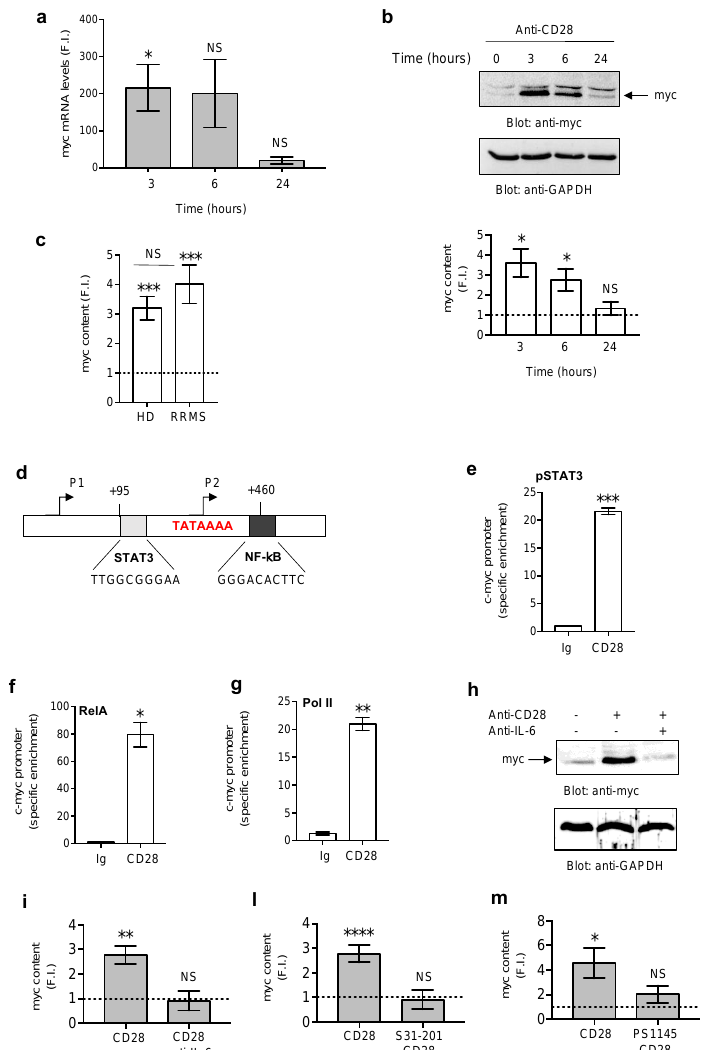
Figure 4. STAT3 and RelA / NF- κ B transcription factors regulate the transactivation of c-myc in response to CD28 stimulation. ( a ) Peripheral blood CD4 + T cells from HDs ( n = 3) were activated for 3, 6 or 24 h with isotype control Ig or anti-CD28.2 Abs and c-myc mRNA levels were measured by real time PCR. The values were expressed as fold induction (F.I.) over isotype control Ig after normalization to GAPDH. Data show the mean ± SEM. ( b ) Western blotting analysis was used to measure c-myc and GAPDH levels in CD4 + T cells from HDs ( n = 3) activated for di ff erent times with anti-CD28.2 Abs or isotype control Ig. Fold inductions (F.I.) were calculated after normalization to GAPDH levels and expressed as mean F.I. ± SEM (lower graph). ( c ) Anti-myc western blotting of CD4 + T cells from HDs ( n = 6) or RRMS ( n = 6) stimulated for 3 h with anti-CD28.2 Abs or isotype control Ig. Fold inductions (F.I.) were calculated after normalization to GAPDH levels and expressed as mean F.I. ± SEM. ( d ) Schematic sequence of the human c-myc P2 promoter gene with TATA box (red) and the specific binding sites for NF- κ B and STAT3. ( e–f ) Anti-pSTAT3 ( e ), anti-RelA ( f ) and anti-Poll II ( g ) ChIP of CD4 + T cells activated for 3 h with isotype control Ig or anti-CD28.2 Abs. Real time PCR with primers specific for the c-myc P2 promoter were performed and the specific enrichment was calculated by the C τ method. Data show the mean ± SEM of one representative out of three HDs. ( h–m ) CD4 + T cells from RRMS patients ( n = 3) were activated as in ( g ) in the presence or absence of 10 µ g mL − 1 neutralizing anti-IL-6 Abs ( h,i ), or 100 µ M S31-201 ( l ), or 10 µ M PS1145 ( m ) and anti-myc and anti-GAPDH western blotting were performed. Fold inductions (F.I.) over isotype control Ig were calculated after normalization to GAPDH levels. Bars show mean F.I. ± SEM and statistical significance was calculated by an unpaired Student’s t test. (*) p < 0.05, (**) p < 0.01, (***) p < s0.001, (****) p < 0.0001. NS = not